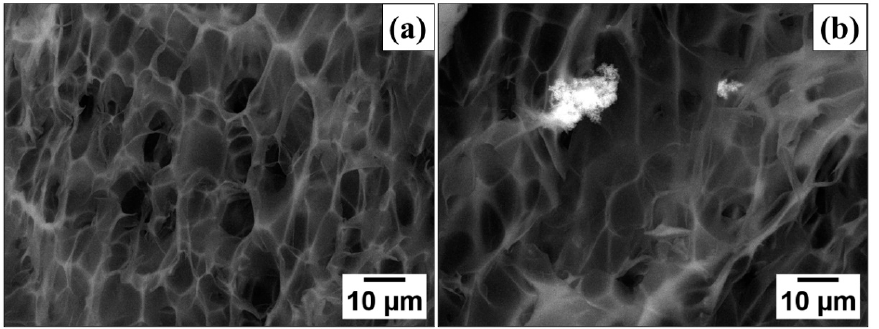
Figure 1. SEM/BSE images of ( a ) PPy-G aerogel, prepared in the absence of BaFe and ( b ) PPy-G-BaFe aerogel, synthesized using 10 wt% of BaFe. Table 1. Iron content, determined by SEM/EDX, and barium content, measured by elemental analysis, for PPy-G aerogel, PPy-G-BaFe aerogels synthesized using various fractions of BaFe, and pristine BaFe. BaFe Fraction, wt%